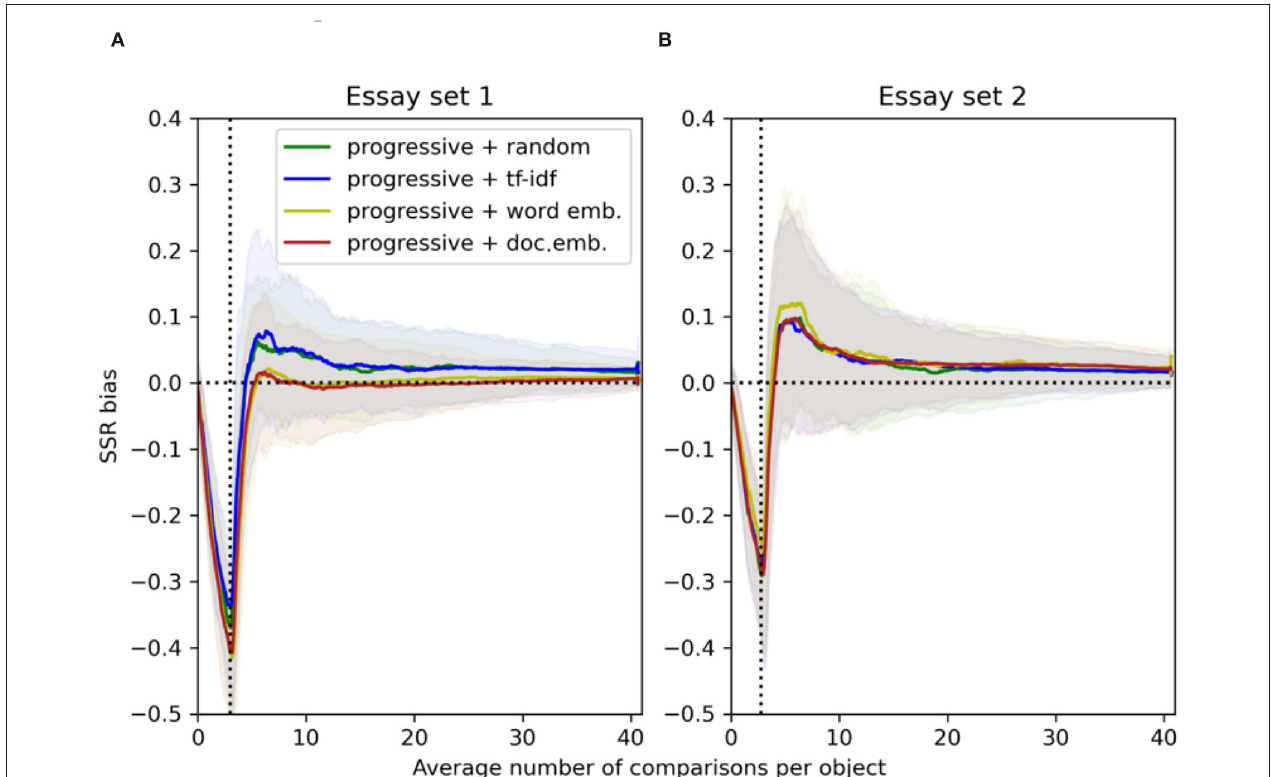
FIGURE 2 | For essay set 1 ( A , N 1 = 141) and 2 ( B , N 2 = 150), SSR bias resulting from the progressive selection with a random component, and a similarity component using tf-idf, averaged word embeddings and document embeddings (100 simulations). The solid lines indicate the mean values and the transparent bands indicate the 95% point-wise confidence